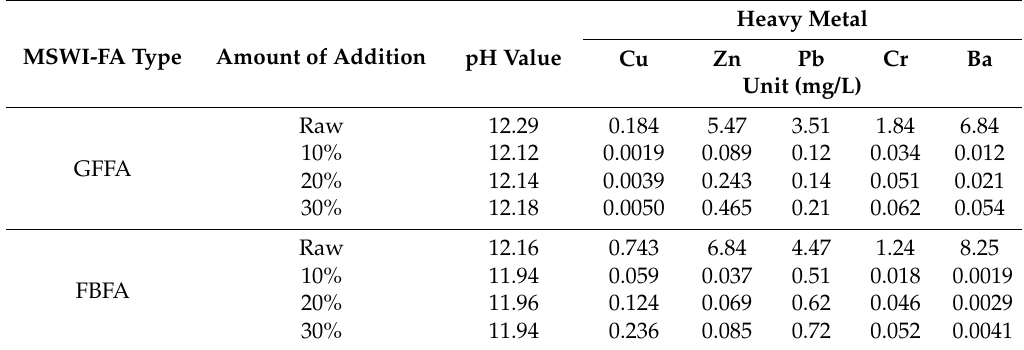
Table 8. The results of the leaching test according to the USEPA SW-846 Method 1312.